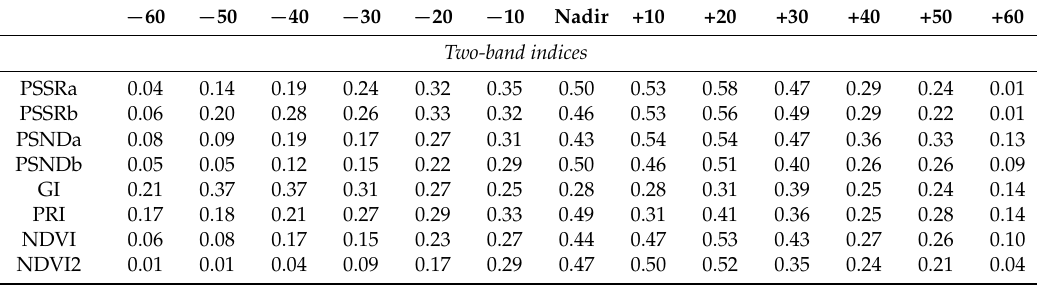
Table 4. Coefficients of determination (R 2 ) between published spectral indices and leaf Chl content in the bottom-layer of wheat canopy at different viewing